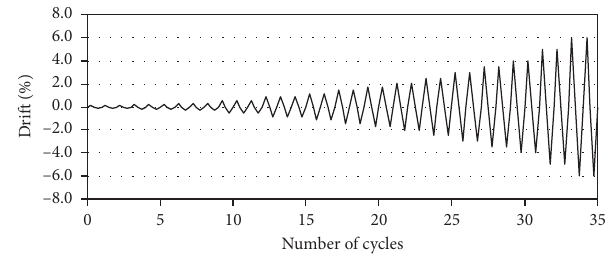
Figure 6: Cyclic loading protocol.